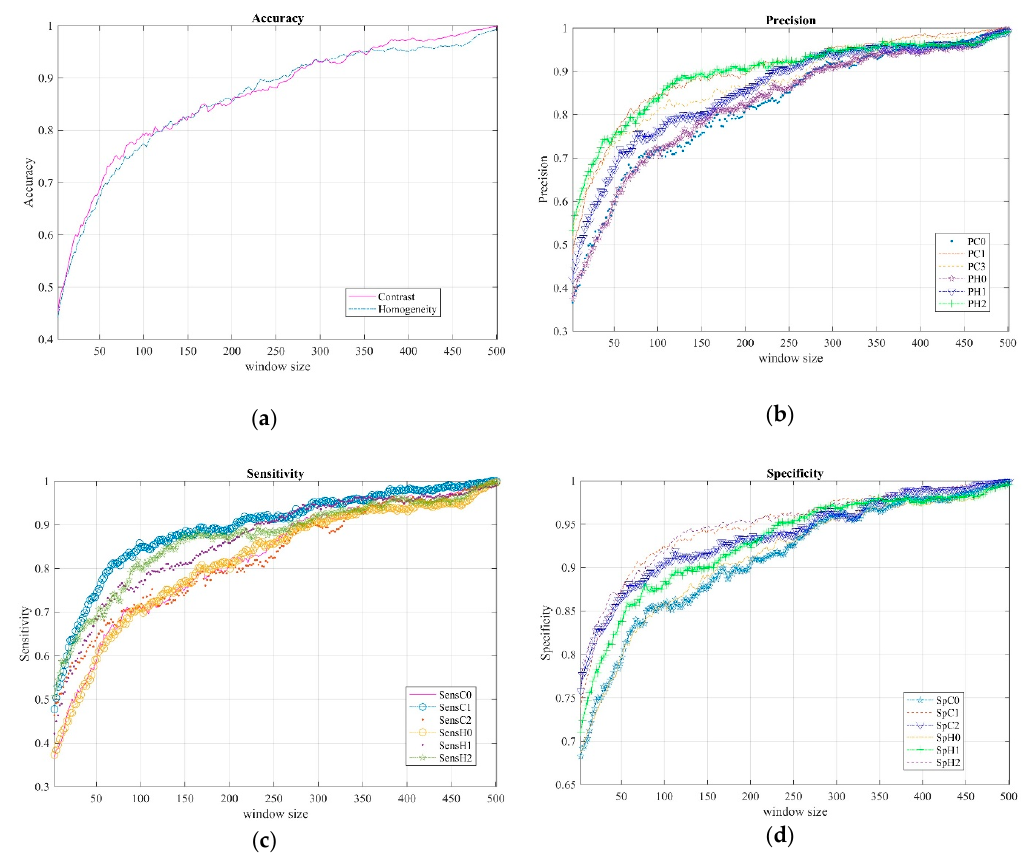
Figure 6. Performance metrics of a BgT classifier for different window sizes. ( a ) Accuracy of contrast (C) and homogeneity (H), ( b ) precision (P), ( c ) sensitivity (Sens), and ( d ) specificity (Sp) of contrast (C) and homogeneity (H) for each class (0, 1, and 2), respectively.